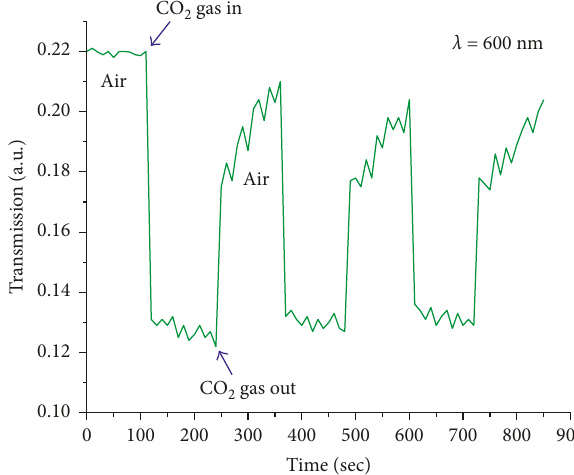
Figure 11: Dynamic CO 2 gas-sensing response of TiO 2 films decorated with AgNPs with maximum thickness